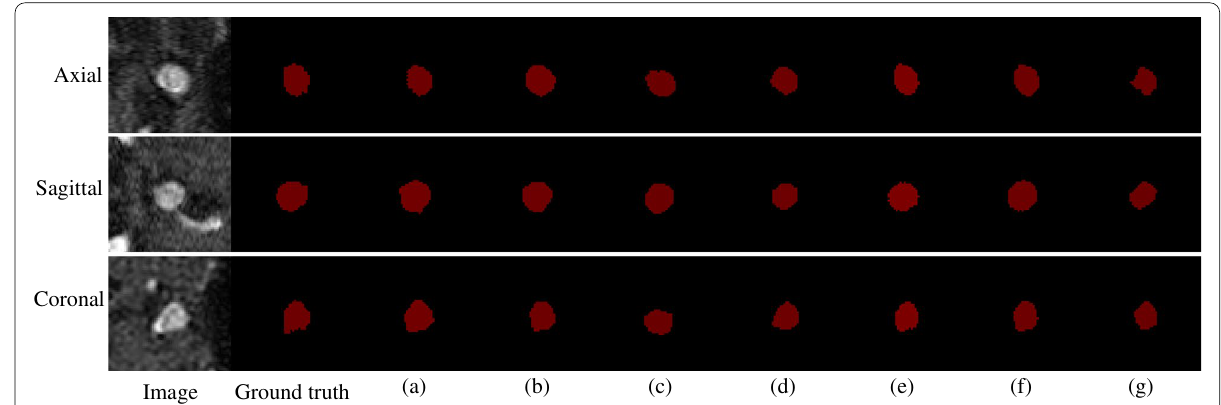
2D CNN; c HeadXNet; d DeepMedic; e GLIANet; +